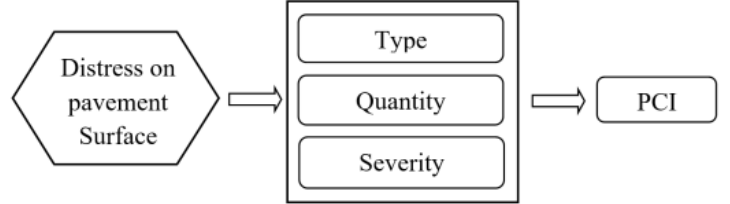
Figure 1. The procedure of the pavement condition index (PCI).